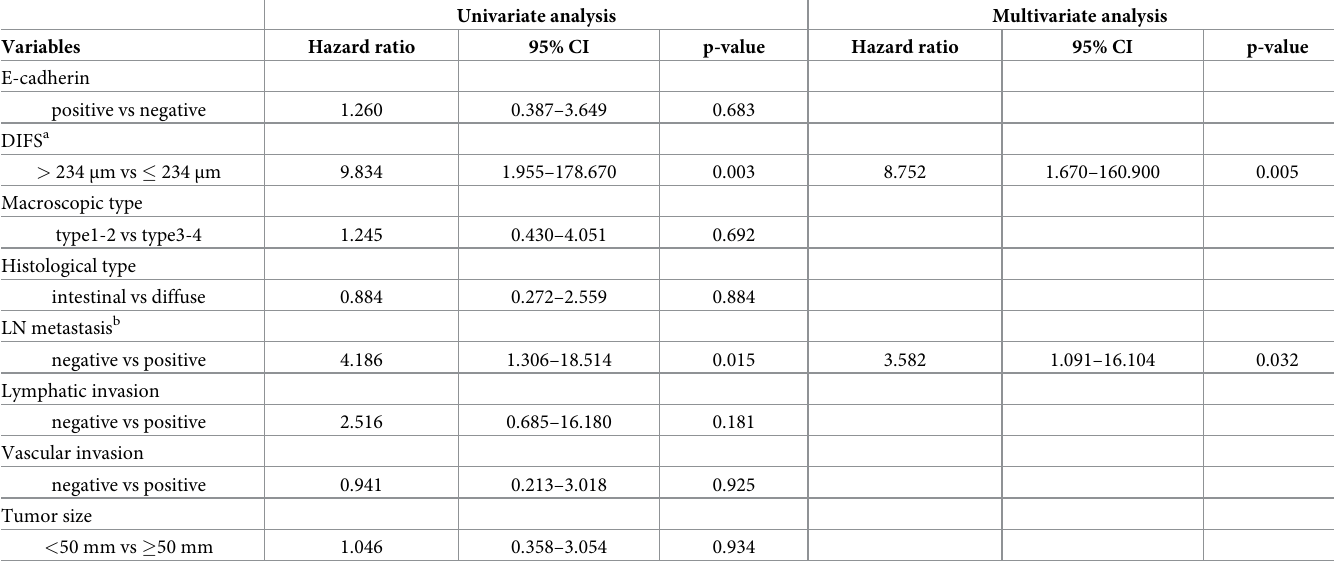
Table 3. Univariate and multivariate analysis with respect to five-year overall